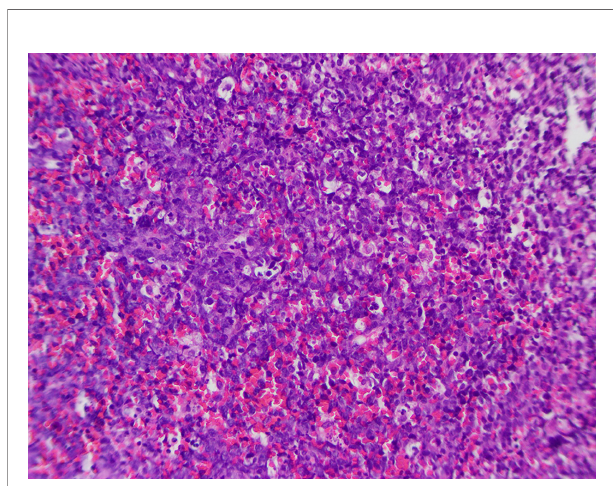
FIGURE 2 | Histologic examination of the right patellar mass reveals the diffuse in fi ltration by atypical